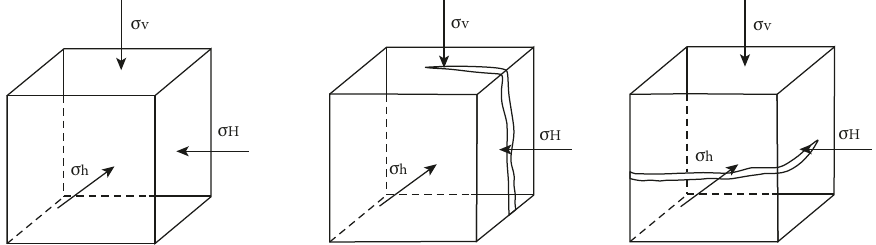
Figure 1: Fracture propagation path.